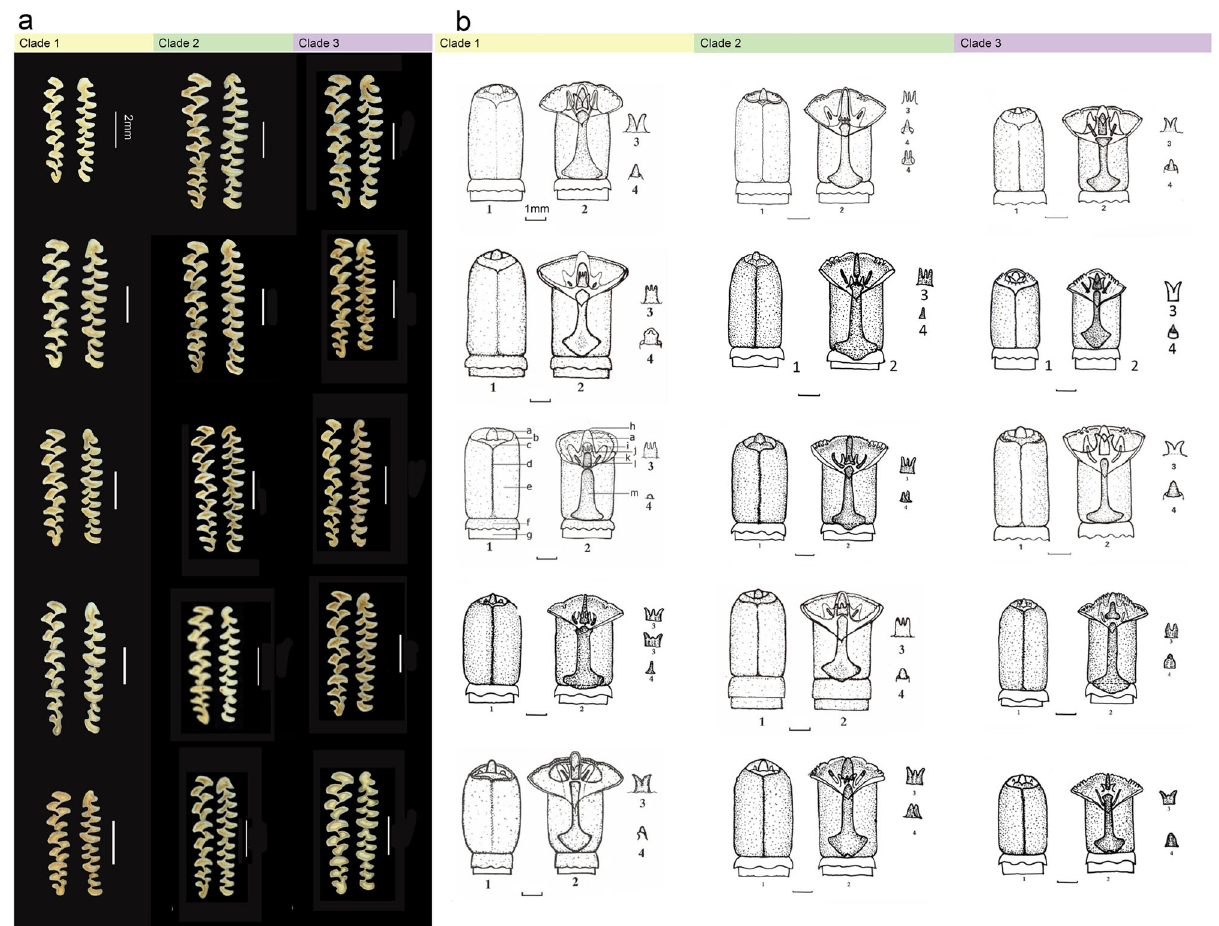
Fig. 2 Comparison of morphological features. a Comparison of tooth rows. b Comparison of glans penes. Numbered views are 1: glans; 2: midventral cut view; 3: urethral lappet; 4: dorsal papilla. Lettered structural features in a1 and a2 are a. distal baculum; b. outer crater; c. inner crater; d. ventral groove; e. glans; f. prepuce; g. penis body; h. station of dorsal papilla; i. lateral baculum (cartilage); j. urethral lappet; k. lateral baculum (bony part); l. distal baculum (bony part); and m. proximal baculum. The taxa are (from top to bottom) Neodon leucurus , N. fuscus , N. linzhiensis , N. forresti, N. irene from Clade 1, N. nyalamensis , N. sikimensis , unidenti fi ed taxon 1 (from Nanyi township, Milin County), unidenti fi ed taxon 2 (from Shergyla Mountains, Linzhi county), unidenti fi ed taxon 3 (from Motuo County, south of the Namchabarwa Mountains) from Clade 2, N. medogensis , unidenti fi ed taxon 4 (from Ridong village, Bershula Mountains, Chayu County), N. clarkei , unidenti fi ed taxon 5 (from Bomi County) and unidenti fi ed taxon 6 (from Chibagou National Nature Reserve, Chayu County) from Clade 3 (refer to Fig. 3 for clade